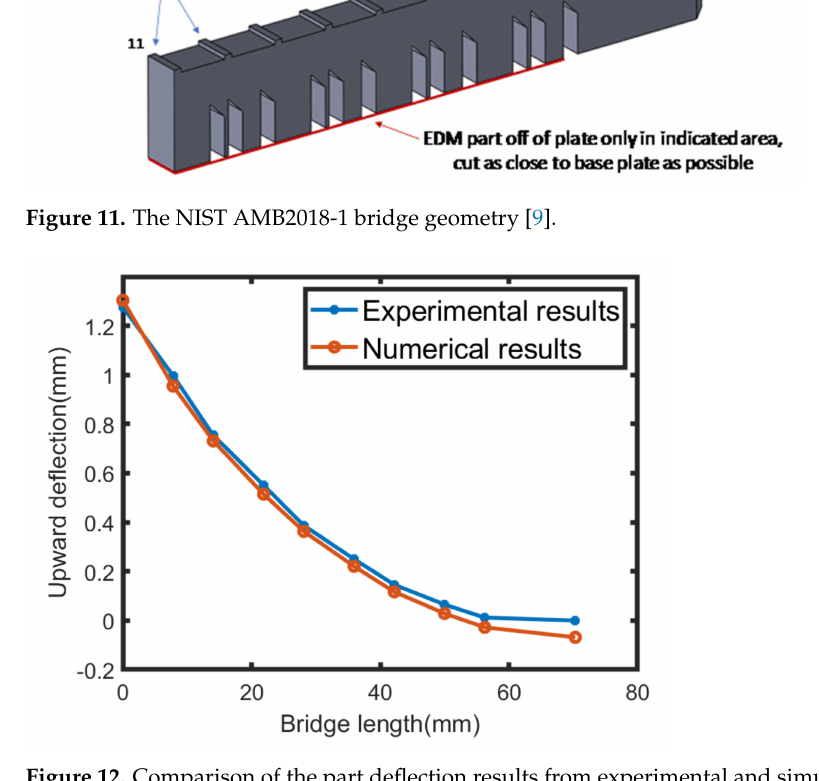
Figure 12. Comparison of the part deflection results from experimental and simulation